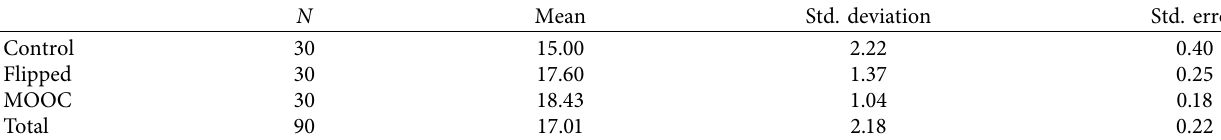
Table 3: Descriptive statistics of reading comprehension posttest.